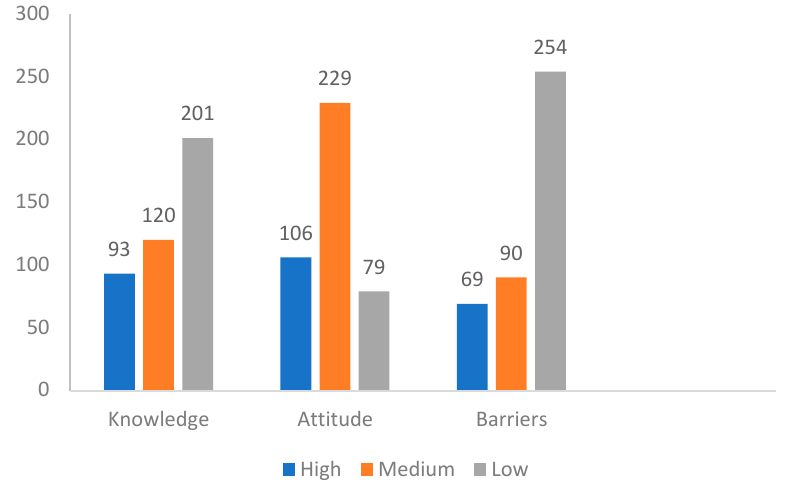
Figure 1. Knowledge, attitude, and barrier categories.